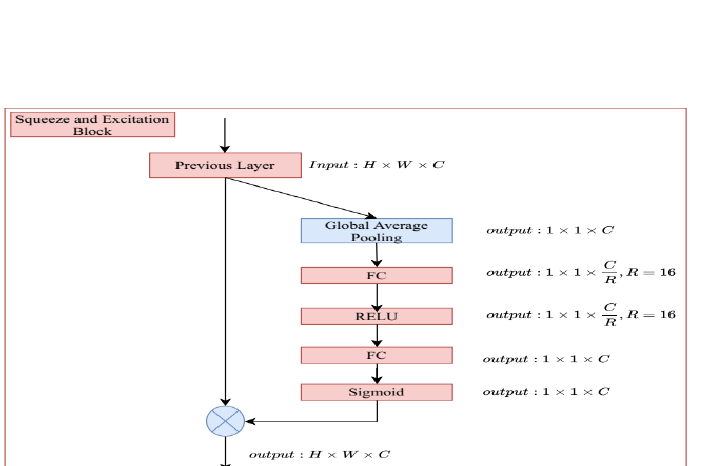
Figure 5. SE-block Architecture, R is the constant used to calculate the number of nodes on the next FC layer (fully connected), C is the number of channels, H is the height of the map features, W is the width of the map features, denotes element-wise operator ⊗